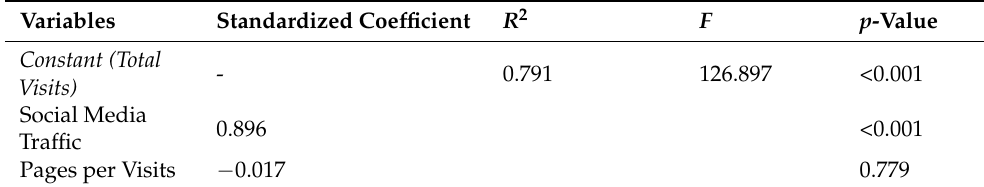
Tables 6 and 7 present the correlation analysis and regression analysis for the H3. Table 7. Regression analysis for H3.